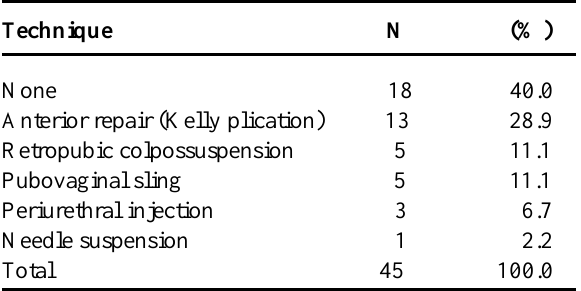
Table 1 – Previous surgical procedures for stress urinary